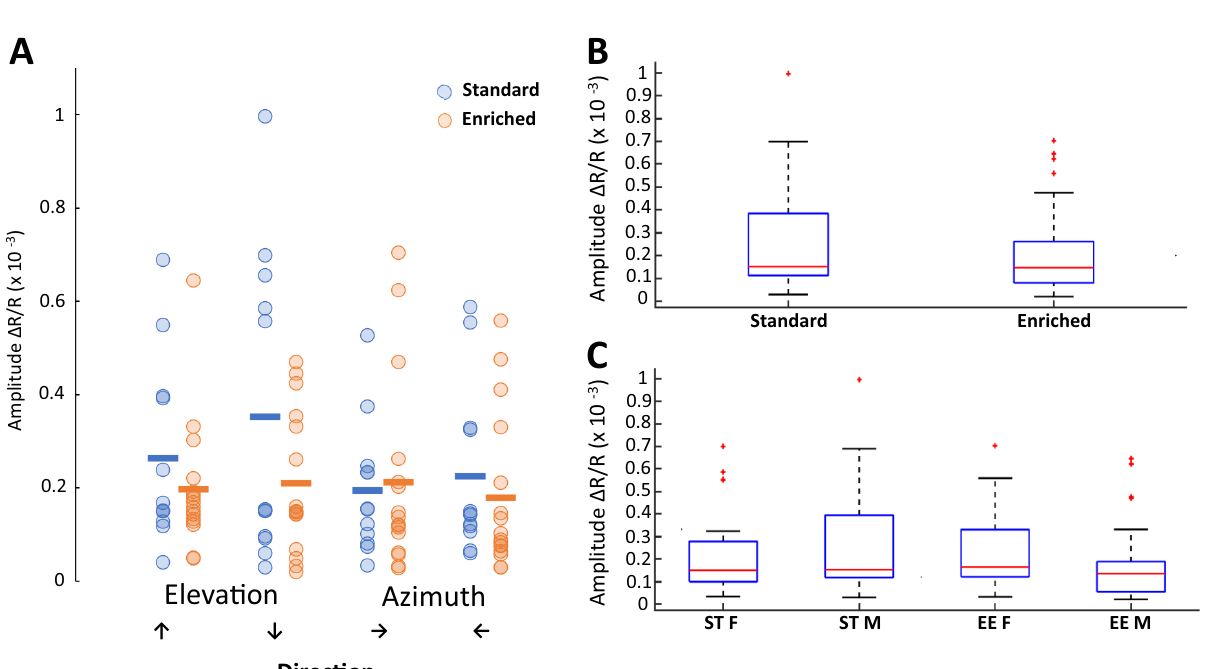
Figure 2. Amplitude in V1. ( A ) Amplitudes as ΔR/R per direction: Up/Down: p = 0.3296; Down/Up: p = 0.1591; Left/Right: p = 0.3466; Right/Left: p = 0.1377 (two-tailed Wilcoxon Rank-sum test). Individual data points represent individual animals. Blue circle: ST mouse (12 mice in total); orange circle: EE mouse (16 in total). Blue line: ST average; orange line: EE average. ( B ) Box plots of overall amplitudes per group (data from A ): p = 0.0985. N = 12 for ST mice and n = 16 for EE mice. ( C ) Box plot of amplitudes per gender in all directions: ST females (n = 5) vs. ST males (n = 7), p = 0.4579; EE females (n = 8) vs. EE males (n = 8), p =